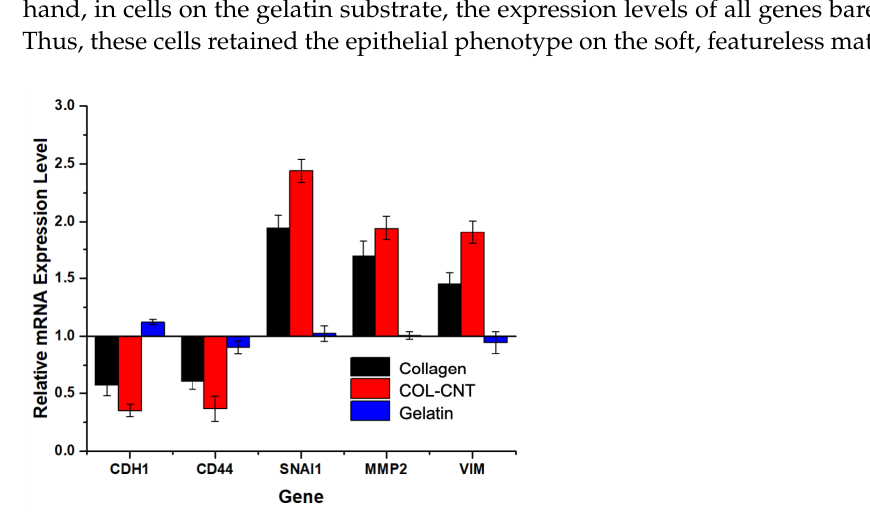
Figure 7. Gene expression profiles of SKOV3 cells grown on collagen, COL-CNT, and gelatin by Day 3. The expression of each gene in cells initially cultured on the plastic petri dish was used as a control to derive the relative mRNA expression.